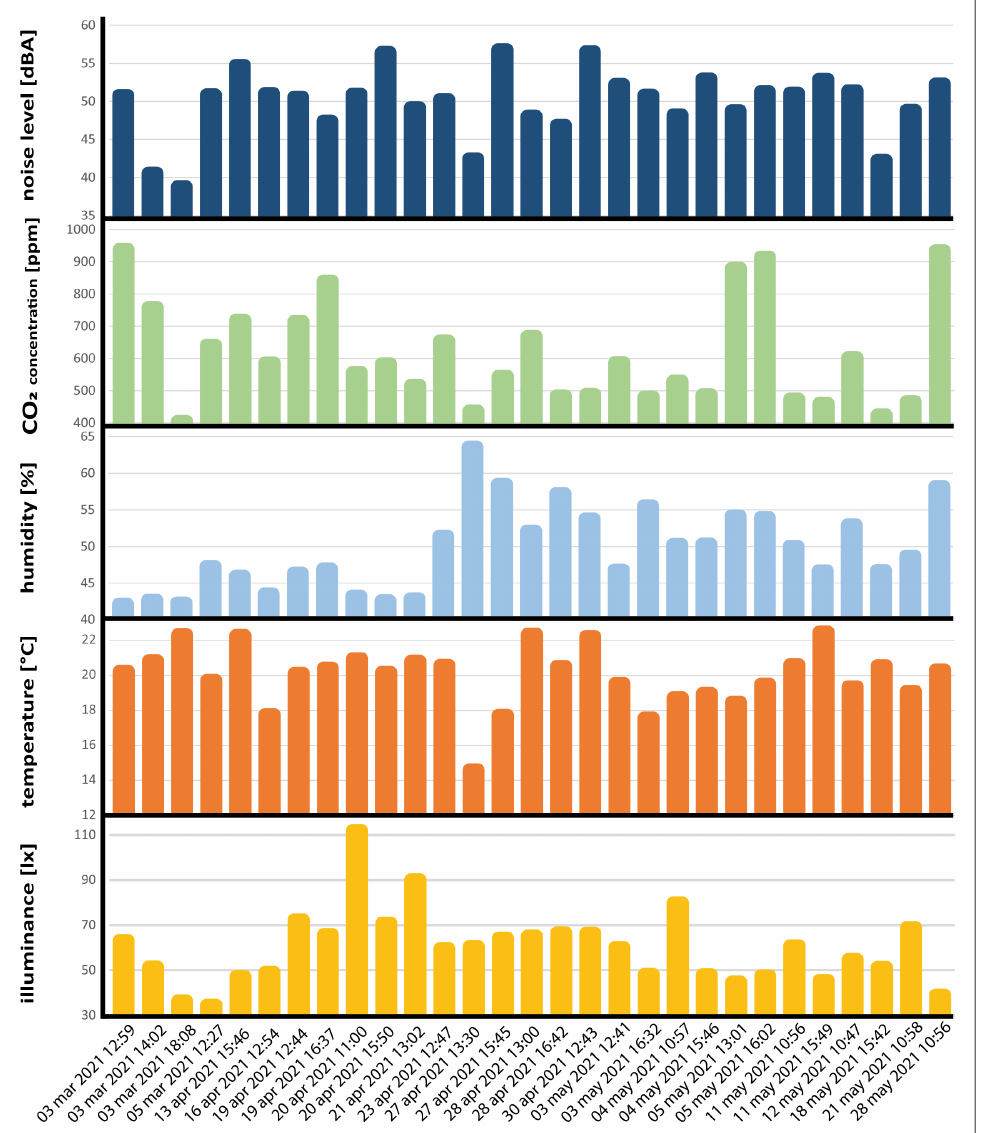
Figure 11. Physical parameter averages per